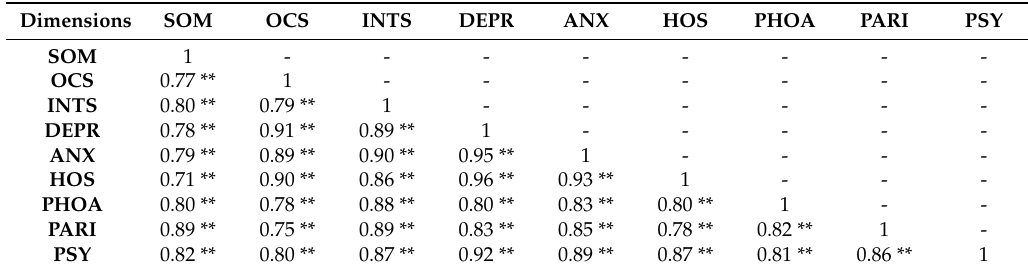
Table 5. Correlations between respondents’ scores in individual dimensions of SCL-90-R.